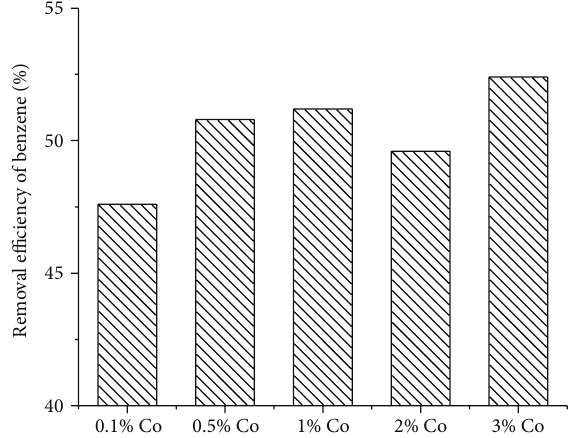
Figure 6: Effect of Co loading amount on benzene removal.